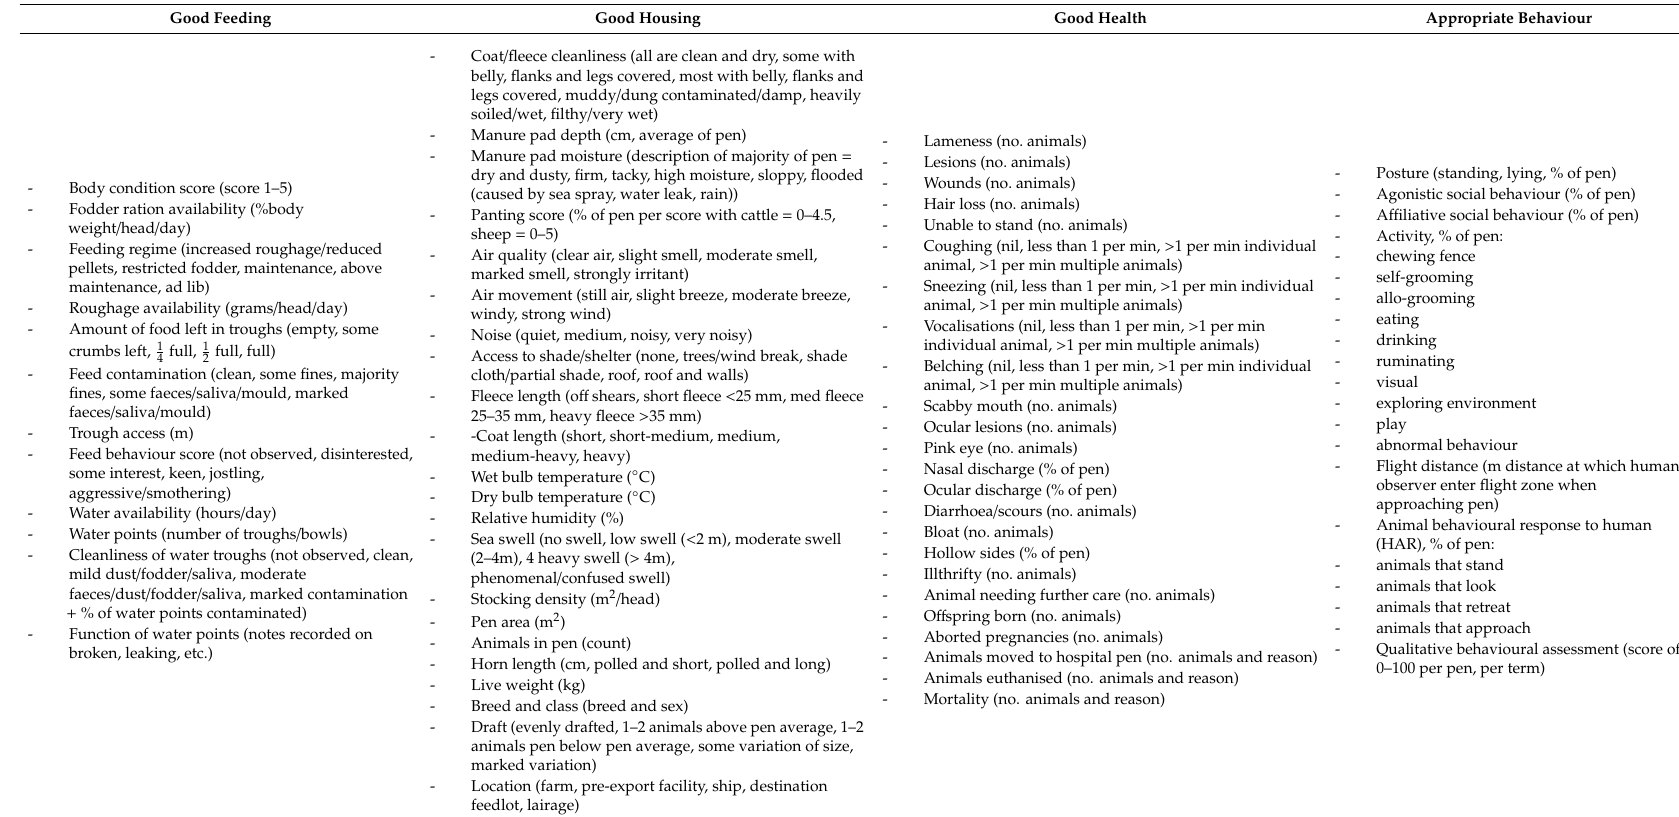
Table 4. Measures with descriptions for the proposed protocol for the Australian livestock export. Measures, unless specified, are to be recorded at a pen level. Good Feeding Good Housing Good Health Appropriate Behaviour